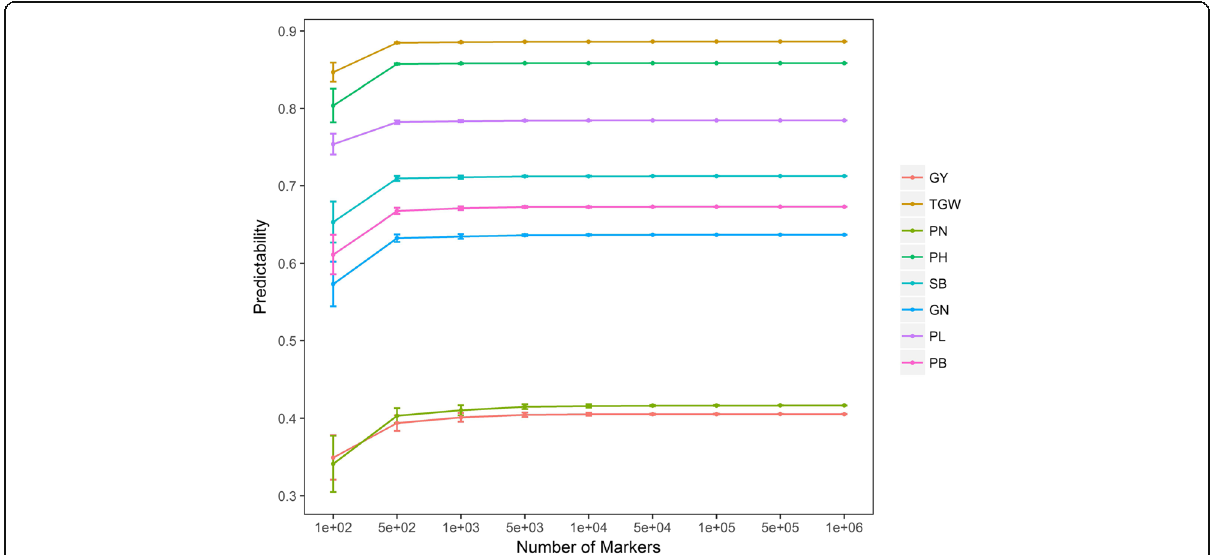
Fig. 3 Effect of the marker density on the predictability. Nine subsets are selected with the marker number varying from 100 to 1,000,000. Fivefold cross-validations are repeated 100 times for each subset of SNP markers. Error bars are constructed using one standard error from the